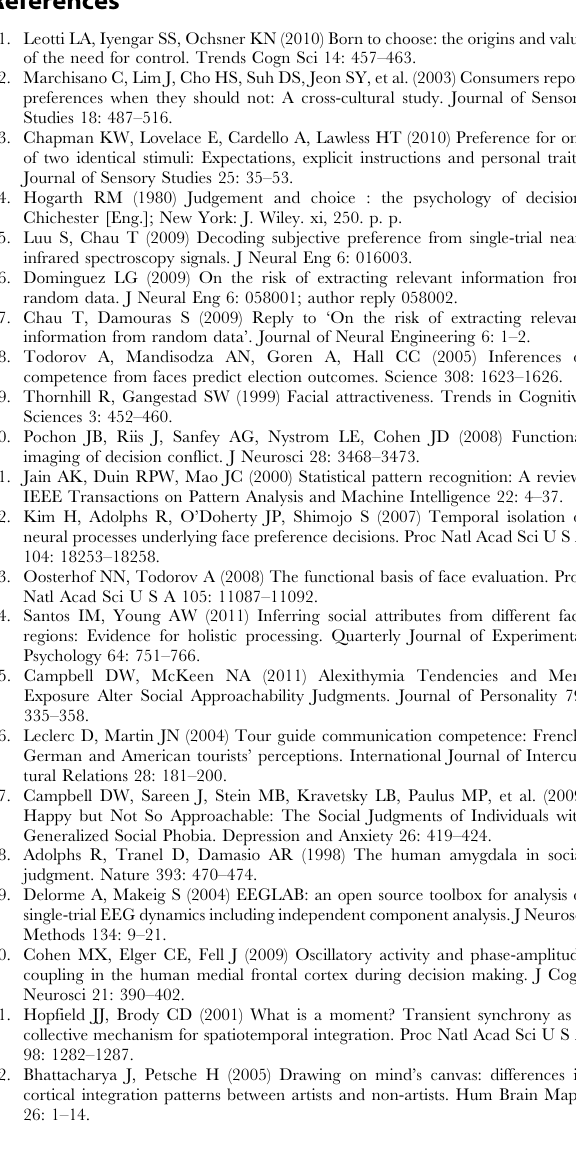
implementing sequential feature selection method; third column represents the prediction accuracy (in percentage) by analysing brain responses to first face (F1X); fourth column represents the prediction accuracy (in percentage) by analysing responses to second face (F2X). The first and last row represents the mean prediction accuracy and standard deviation for CGM and averaged PAM, respectively. The Standard deviation for CGM model and individual participants are calculated across repetitions while the standard deviation of PAM model is across participants. Table S2 The classification accuracy for different